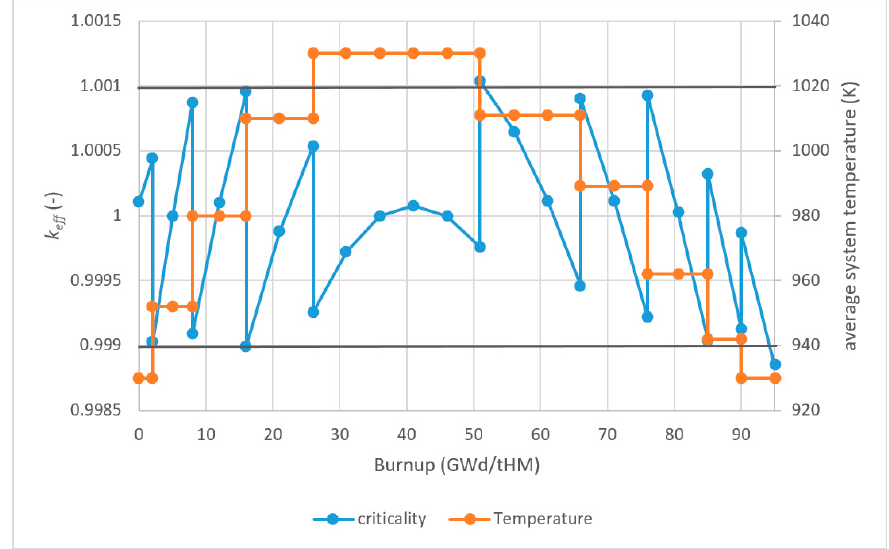
Figure 6. Criticality over burnup for the temperature varied system with the criticality given on the left axis and the system averaged temperature on the right axis for the close to eutectic system.